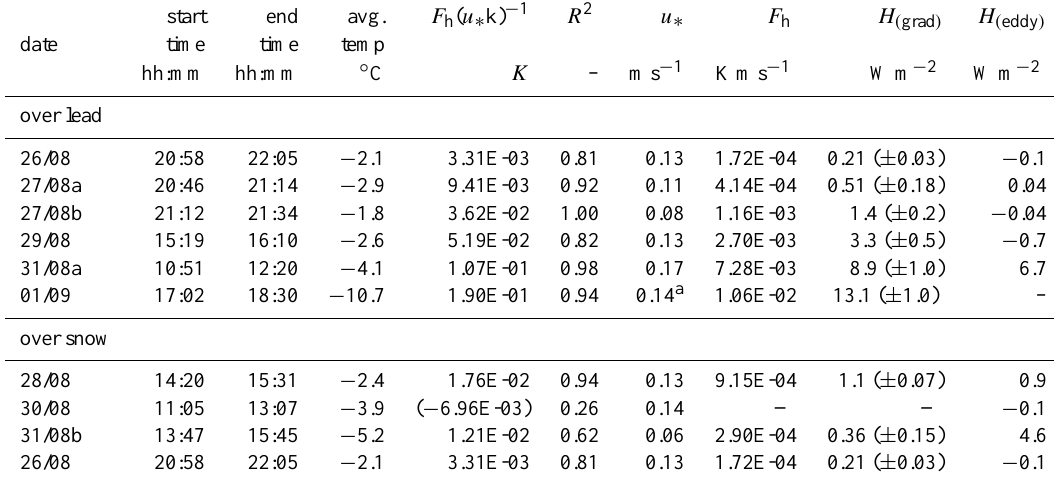
Table 3. Summary of temperature slope parameters, kinematic sensible heat flux F h , and dynamic sensible heat flux H over the lead and snow surfaces; values in parentheses are discarded due to rejection by standard errors or by low coefficients of determination R 2